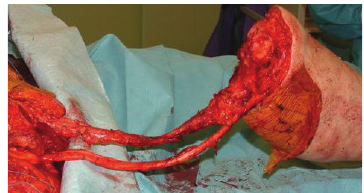
Figure 2: An intraoperative picture after resection of a dedi ff eren- tiated liposarcoma of the distal part of the thigh. The femoral vessels could be preserved because of no tumor infiltration. See below the vessels the sciatic nerve.